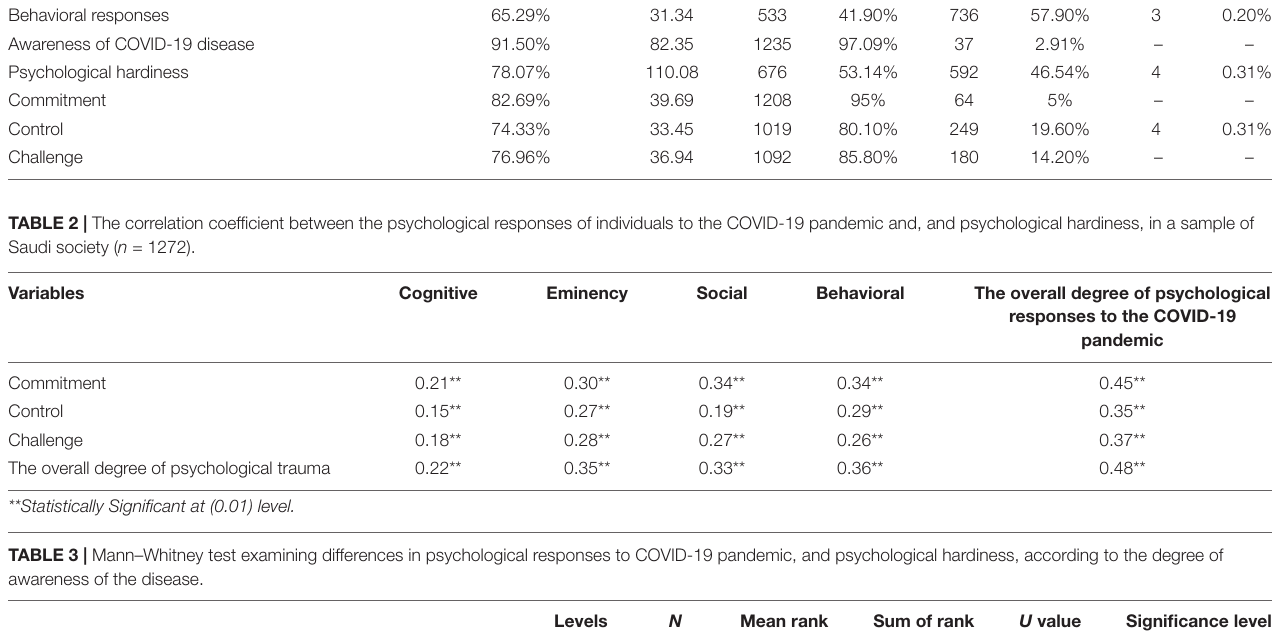
Commitment Challenge